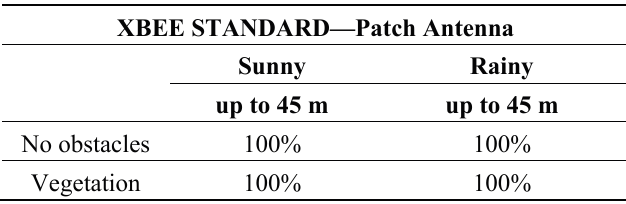
Table 4. ZigBee reliability